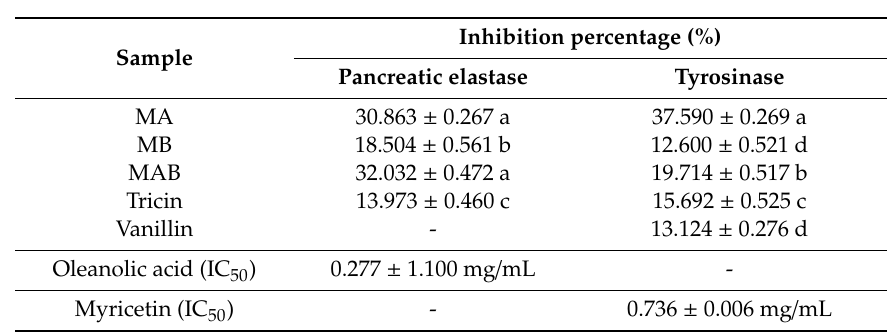
Table 3. Inhibitory activities on pancreatic elastase and tyrosinase of momilactones A, B, and tricin at 2 mg /